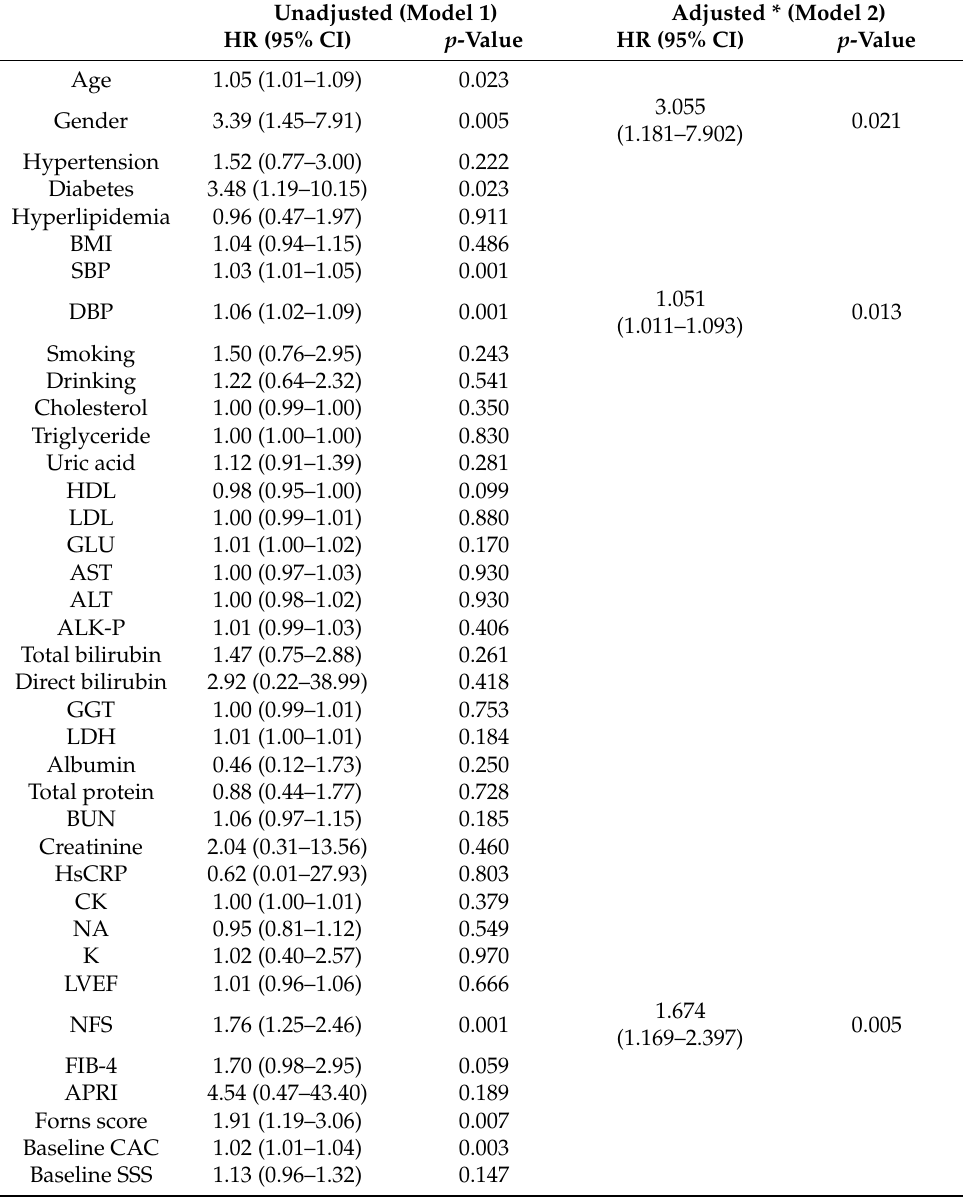
Table 3. Association between baseline biomarkers and SSS